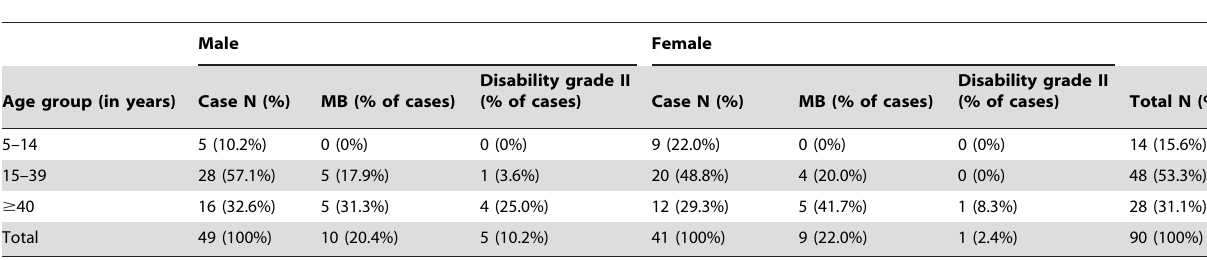
Table 2. General characteristics of the leprosy cases in the analysis